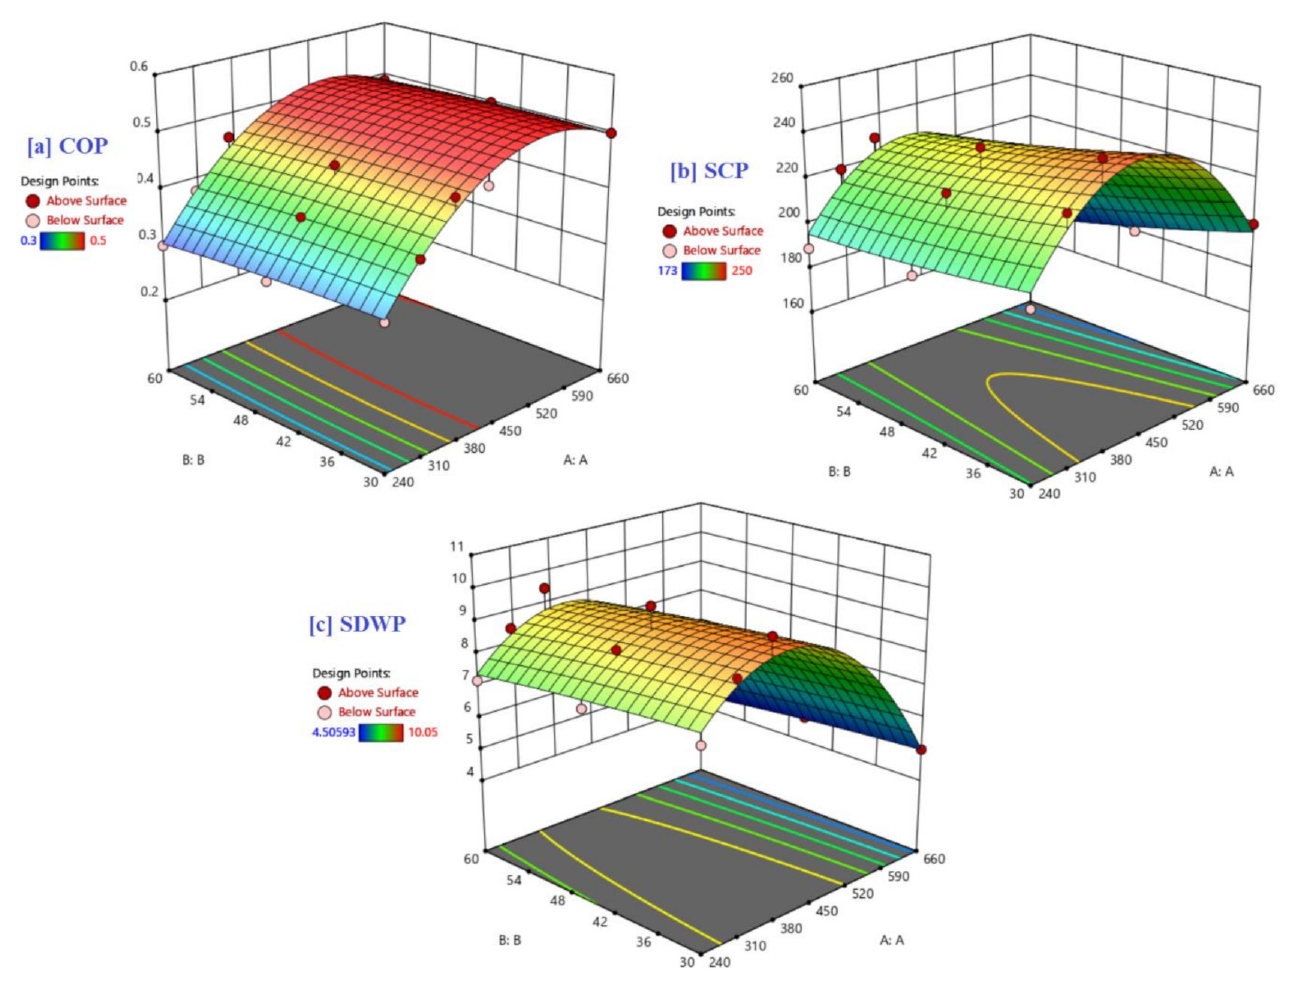
Figure 2. 3-D response surface plots for output responses ( a ) COP; ( b ) SCP, and ( c )